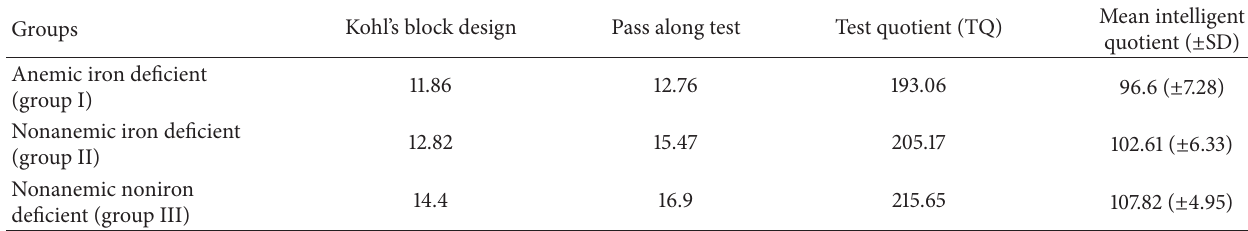
Table 4: The mean scores in Kohl’s block design, pass along test, and mean IQ